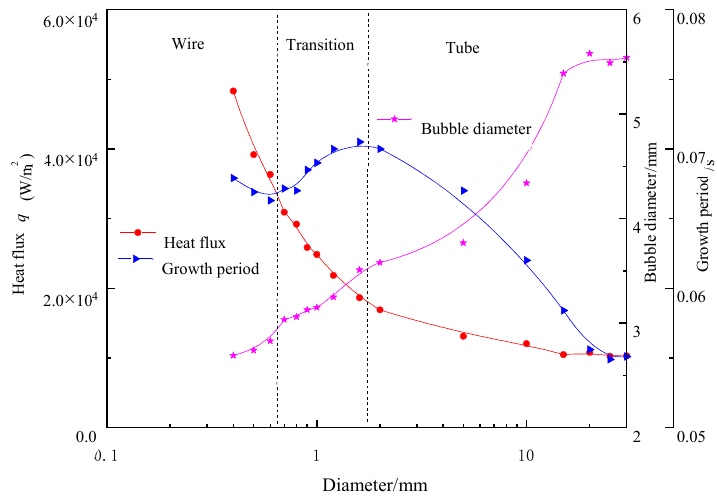
Figure 7. The thermal performance with different cylinder diameters.